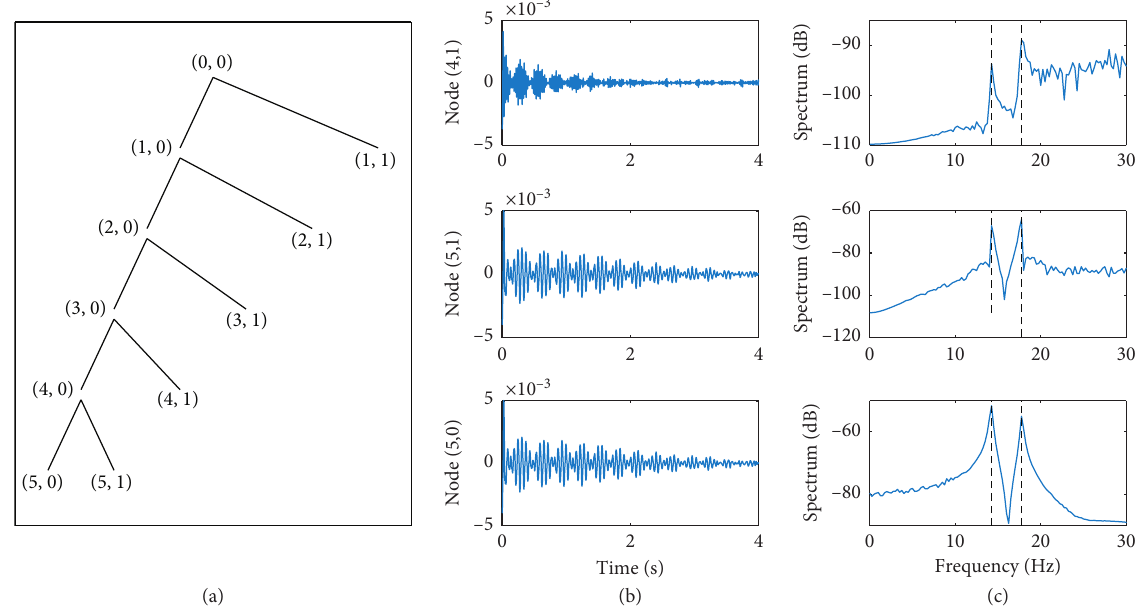
Figure 12: Results of the wavelet packet transform. (a) The optimized best decomposition tree. (b) Reconstruction data on nodes (4, 1), (5, 1), and (5, 0), with (c) their corresponding Fourier